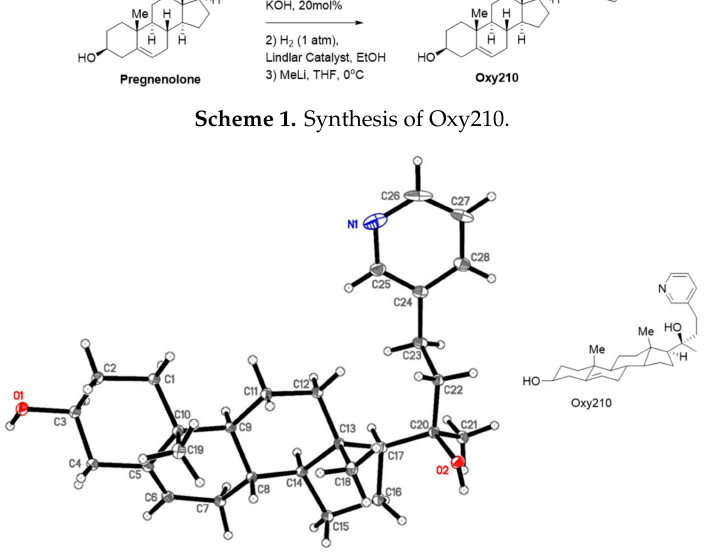
Figure 2. Ortep representation of Oxy210 in the solid